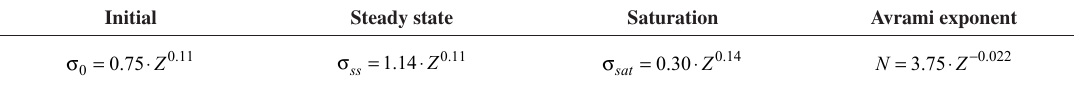
Table 3. Parameters equation applied in Equations 2 and 5 to predicting the flow curves behavior. Initial Steady state